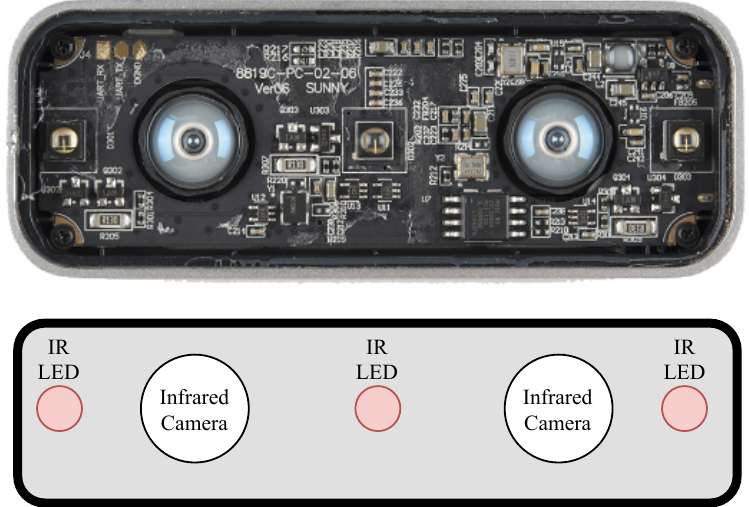
Figure 1. Photograph and labelled sketch of the stereoscopic infrared camera array within a Leap Motion Controller, illuminated by three infrared light-emitting diodes (IR LEDs).